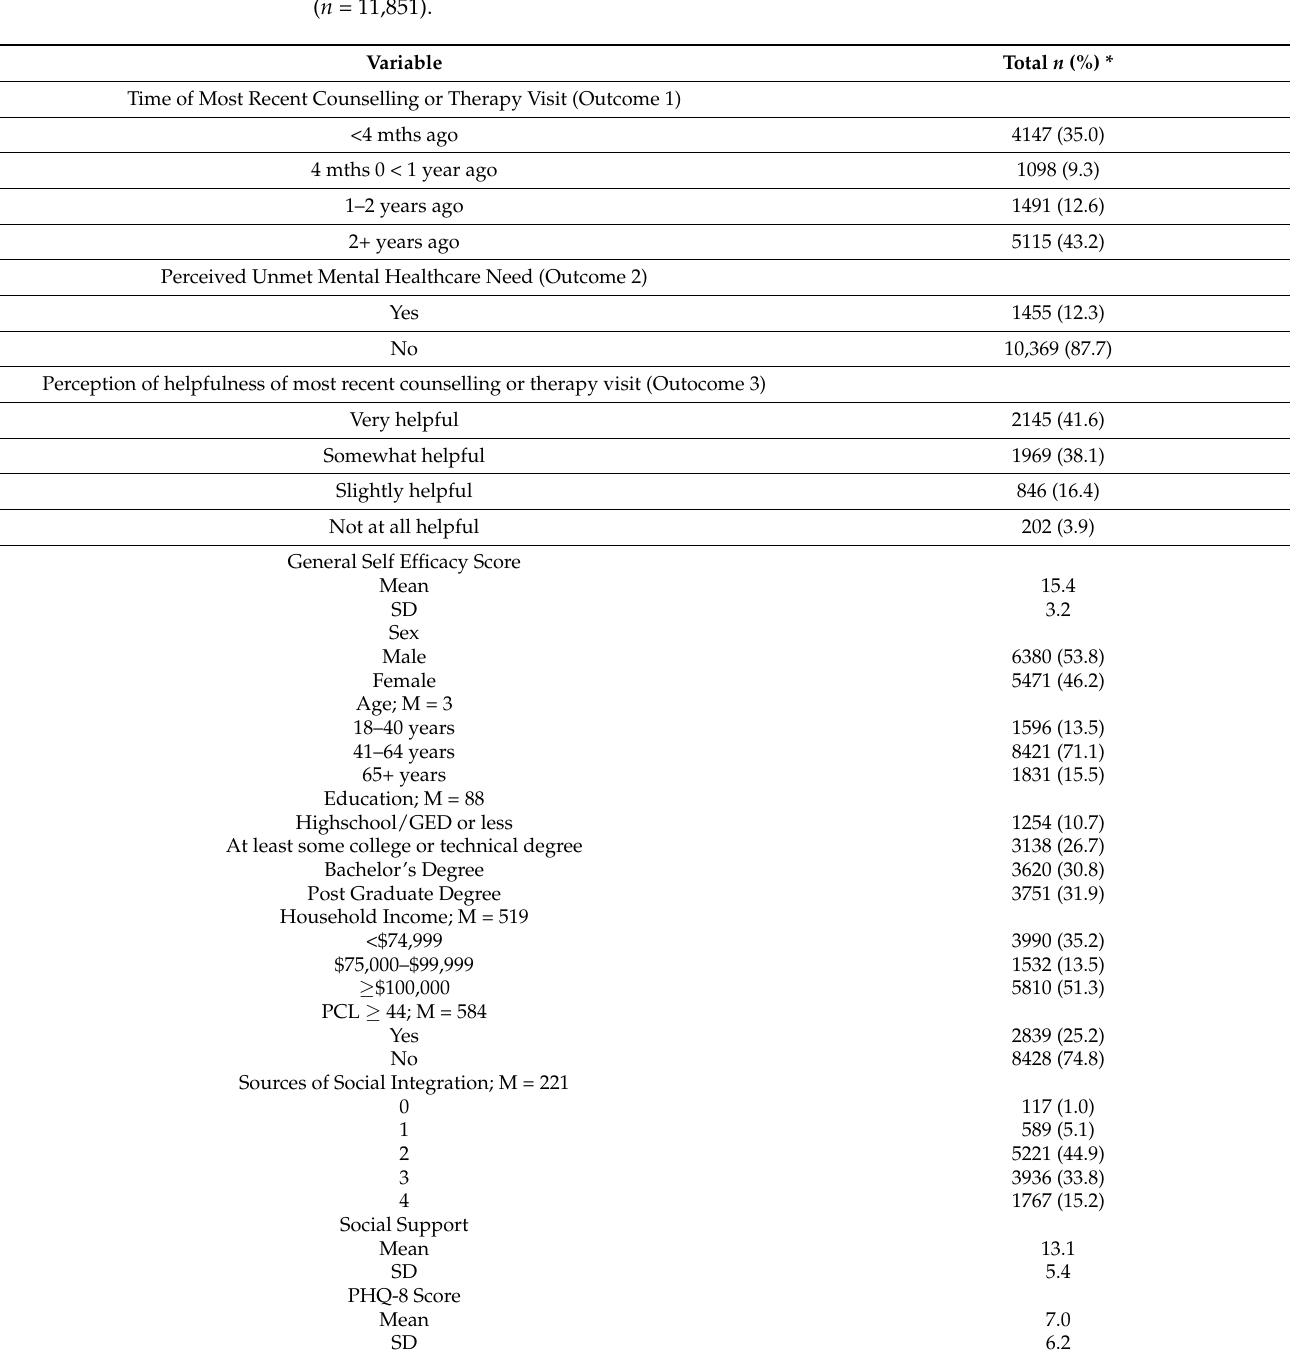
Table 1. Totals for Sociodemographic and Mental Health Characteristics of World Trade Center Health Registry Enrollees who had at least one session of counselling or therapy after 9/11, 2015–2016 ( n = 11,851). Variable Total n (%)